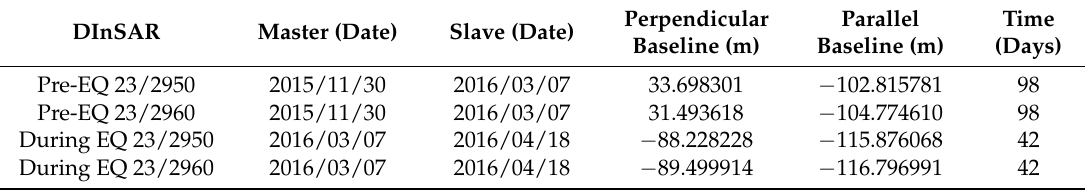
Table 2. Perpendicular and parallel baselines and time intervals of DInSAR